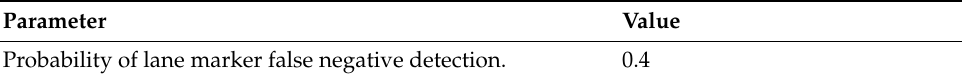
Table A11. Distributions of Scenario F parameters. Ego initial state parameters are identical as in Scenario